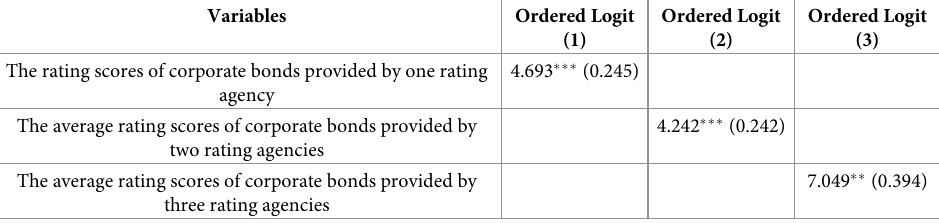
Table 10. Robust results of rating